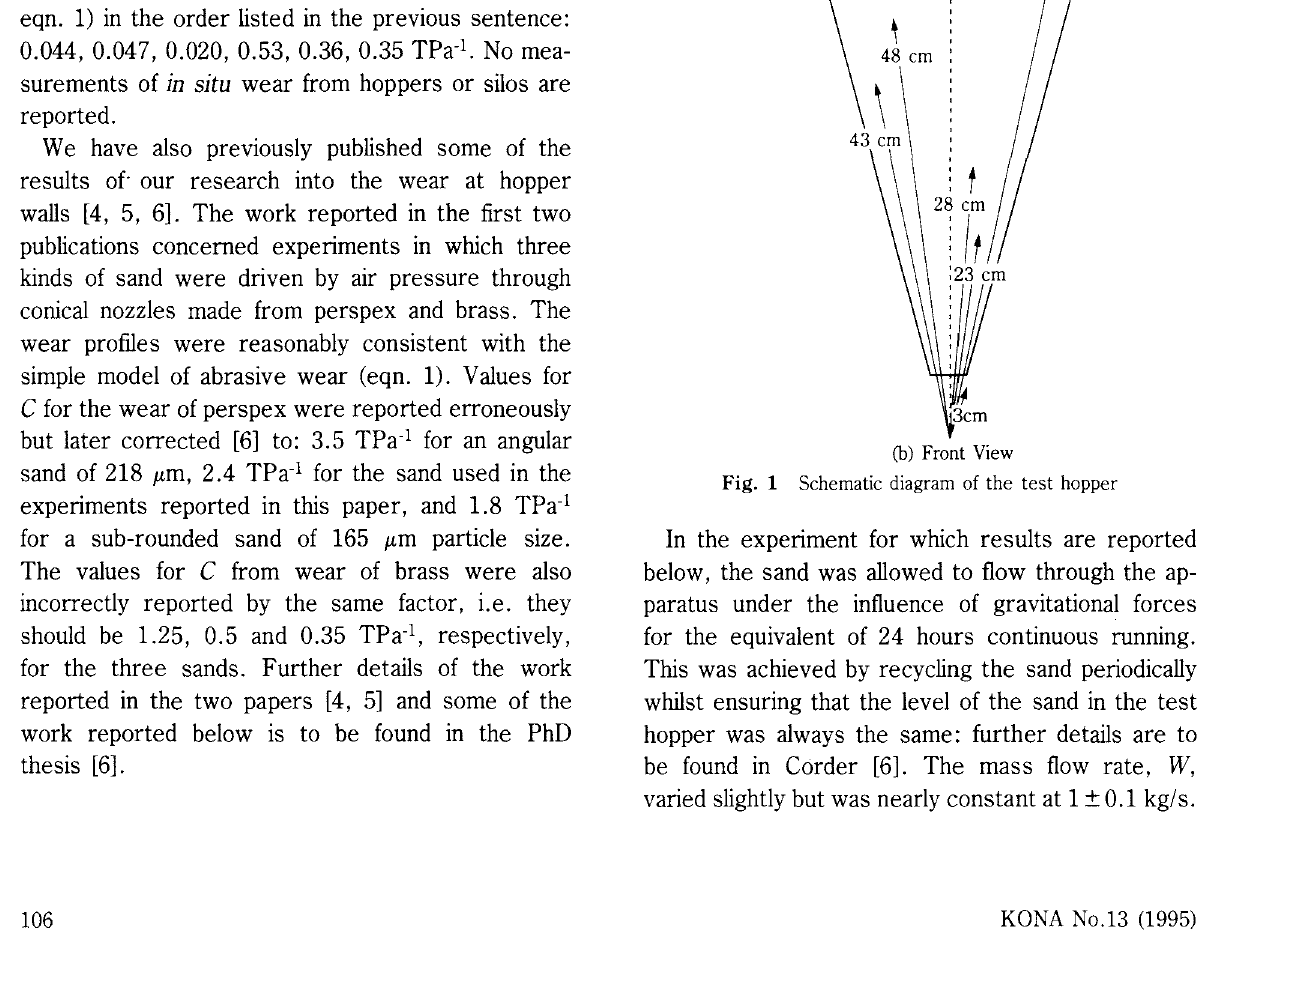
Fig. 1 Schematic diagram of the test hopper In the experiment for which results are reported below, the sand was allowed to flow through the ap paratus under the influence of gravitational forces for the equivalent of 24 hours continuous running.